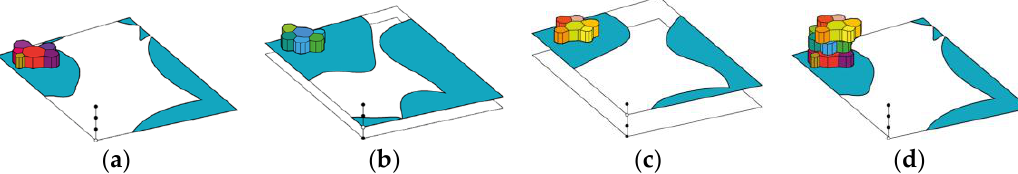
Figure 3. An example of positioning in the wind calm zone: ( a ) First floor; ( b ) Second floor; ( c ) Third floor; ( d ) The composition of all levels.